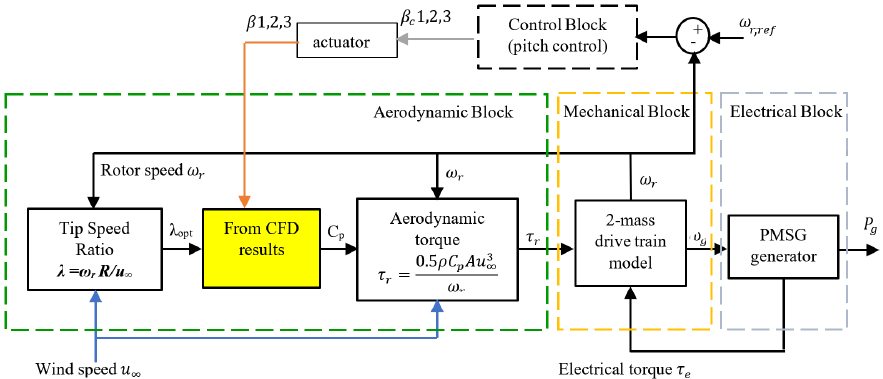
Figure 2. Main components of an H-type VAWT